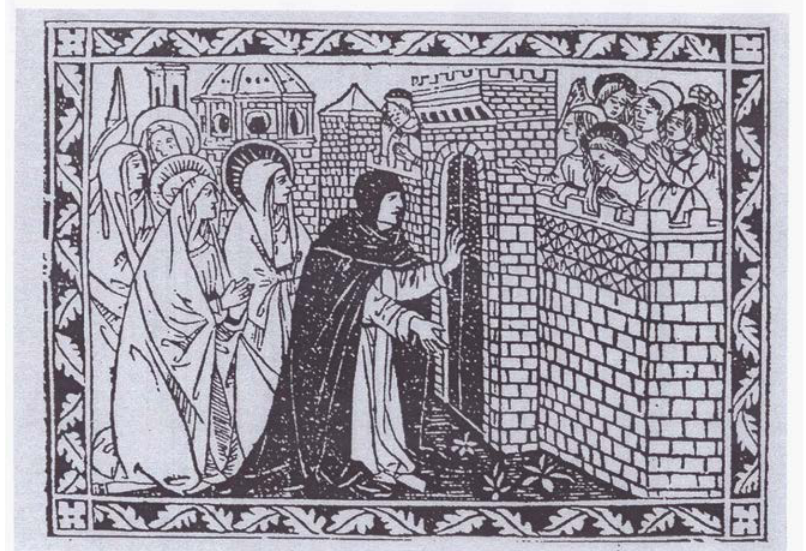
Figure 11 – Girolamo Savonarola, Compendio di rivelatione , ad instantia di ser Piero Pacini da Pescia, Firenze 23 aprile 1496, f. 28v (BNCF, Sav. 146). By permission of Ministero per i beni e le attività culturali / Biblioteca Nazionale Centrale.